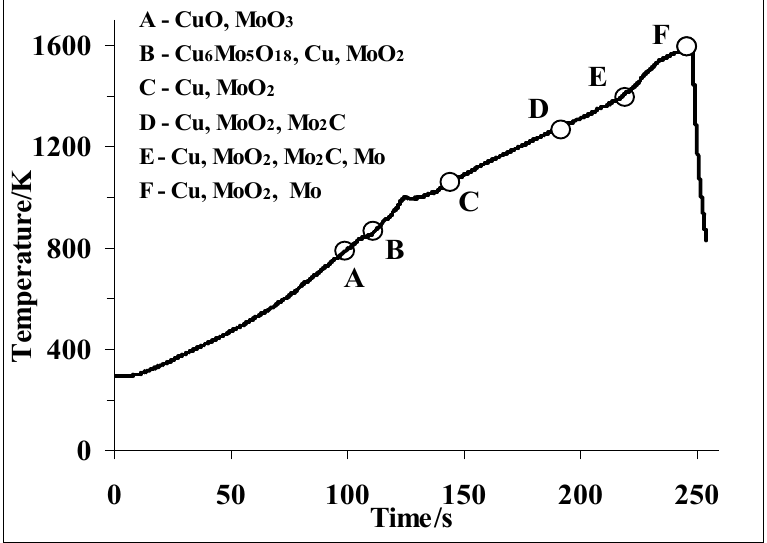
Figure 10. The heating thermogram of the CuO + MoO 3 + 3C mixture with the XRD analysis results of the quenched samples at different characteristic temperatures, A—T = 803, B—913, C—1023, D—1273 E—1393, F—1573 K. V h = 300 K min − 1 .